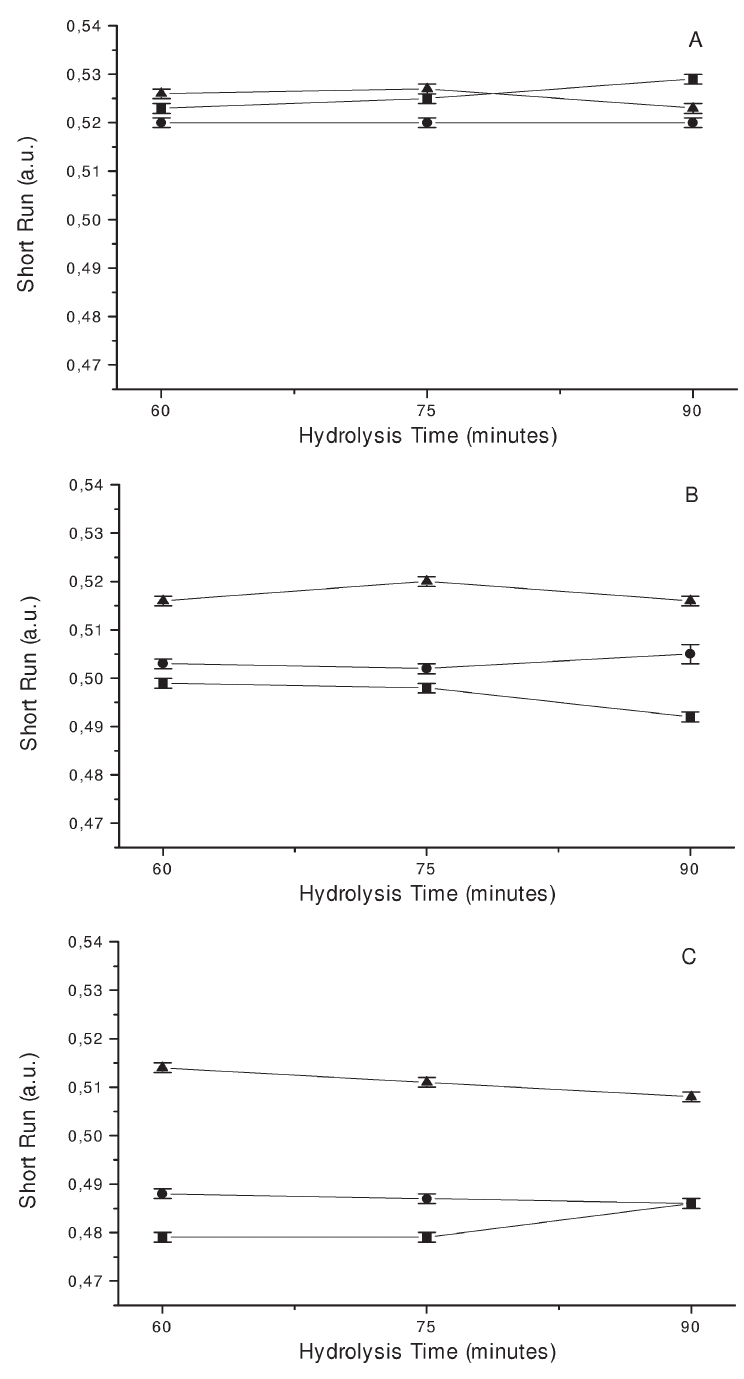
Fig. 6. Mean values ( (cid:6) SEM) of short run in the plateau range of hydrolysis curve for lymphatic cells (A), epithelial cells from buccal mucosa (B) and uterine myometrial cells (C) fixed by different types of fixatives: (cid:4) – Delaunay, (cid:15) – Saccomanno, N – air-drying with postfixation in modified Böhm–Sprenger